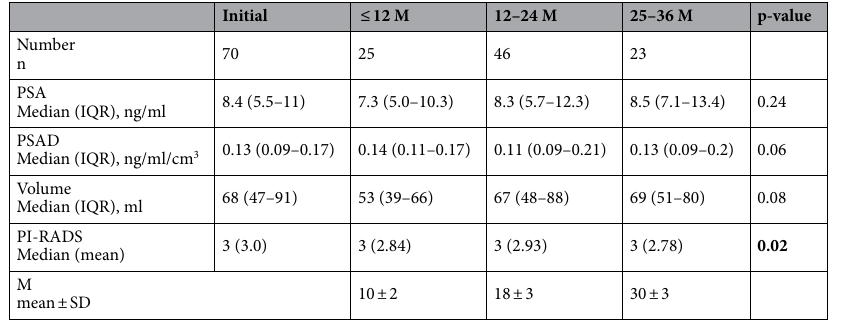
Table 3. Follow up of patients without PCA. PSA value: prostate specific antigen; PSAD: prostate specific antigen density; PI-RADS: Prostate Imaging Reporting and Data System; IQR: interquartile range; M: months; n: number. Significant values are given in